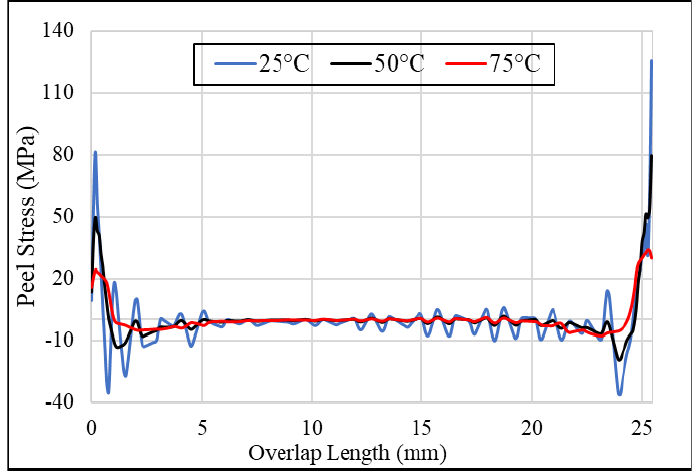
Figure 6. Peel stress distribution at location A of SLJ with neat adhesive at different temperatures.